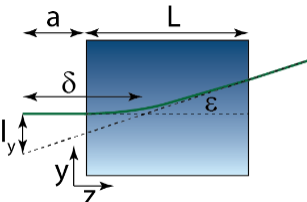
Fig. 1. Geometry of light refraction of a 2D schliere with a gradient in y-direction